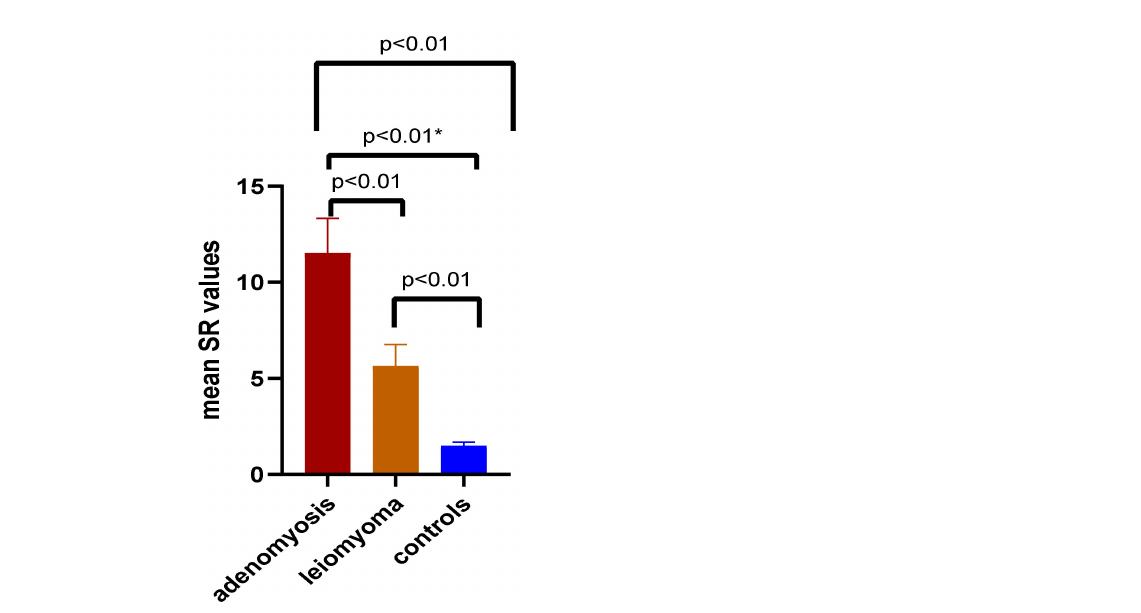
Figure 4. Comparison of mean SR values between adenomyotic, leiomyoma lesions and controls. Legend: SR—strain ratio; *—Mann–Whitney test was used ( t test with Welch’s correction was used for other comparisons of two data sets).